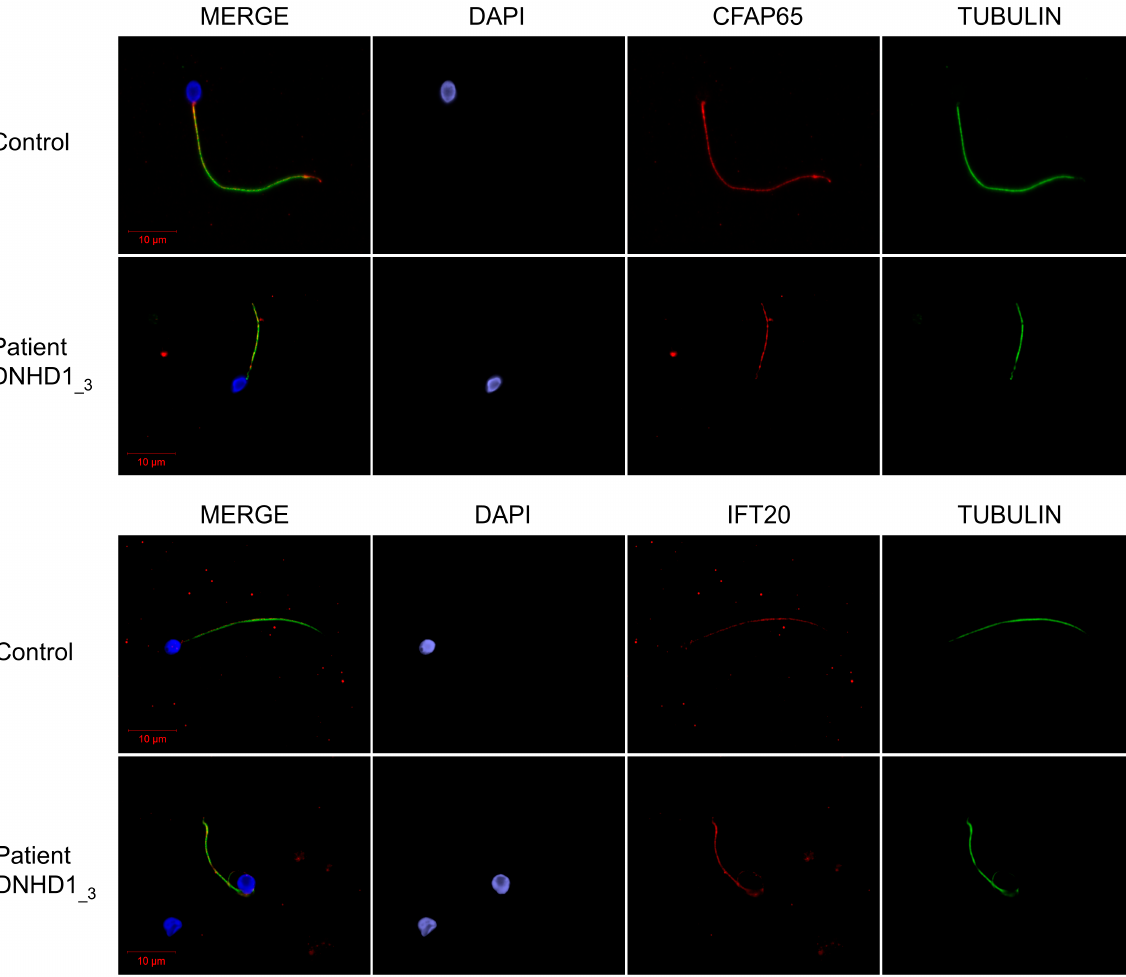
Figure 4. CFAP65 and IFT20 immunostainings of sperm cells from DNHD1 patients. Sperm cells from a fertile control and DNHD1_3 stained with anti-CFAP65 (red) and anti-acetylated tubulin (green) antibodies. DNA was counterstained with DAPI (blue). CFAP65 immunostaining is present throughout the flagellum with no differences between control and patient. Sperm cells from a fertile control and DNHD1 _3 stained with anti-IFT20 (red) and anti-acetylated tubulin (green) antibodies. DNA was counterstained with DAPI (blue). Immunostaining for IFT20 was comparable with control, suggesting that IFT may be not directly affected by mutations in DNHD1. Scale bars: 10 µm.